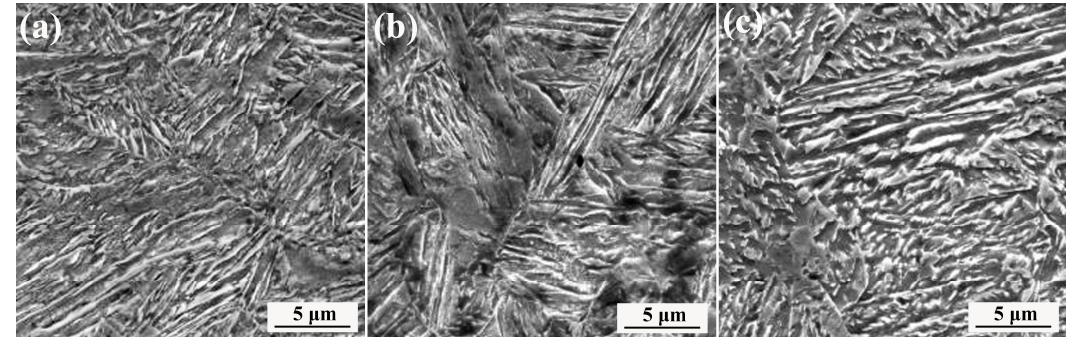
Figure 3. SEM micrographs of three low ‐ carbon bainitic steels before heating treatment: ( a ) base, ( b ) Cr addition, and ( c ) Cr and Al addition.